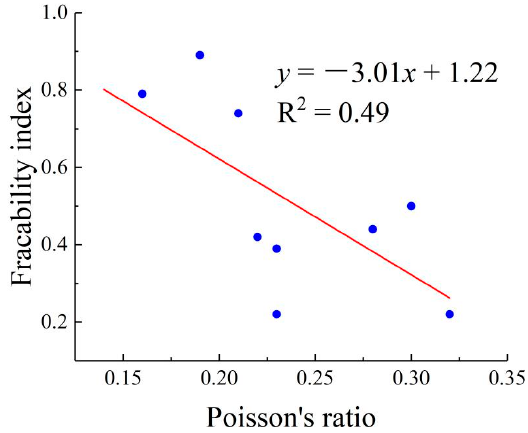
Figure 19. The relationship between fracability index and Poisson’s ratio.